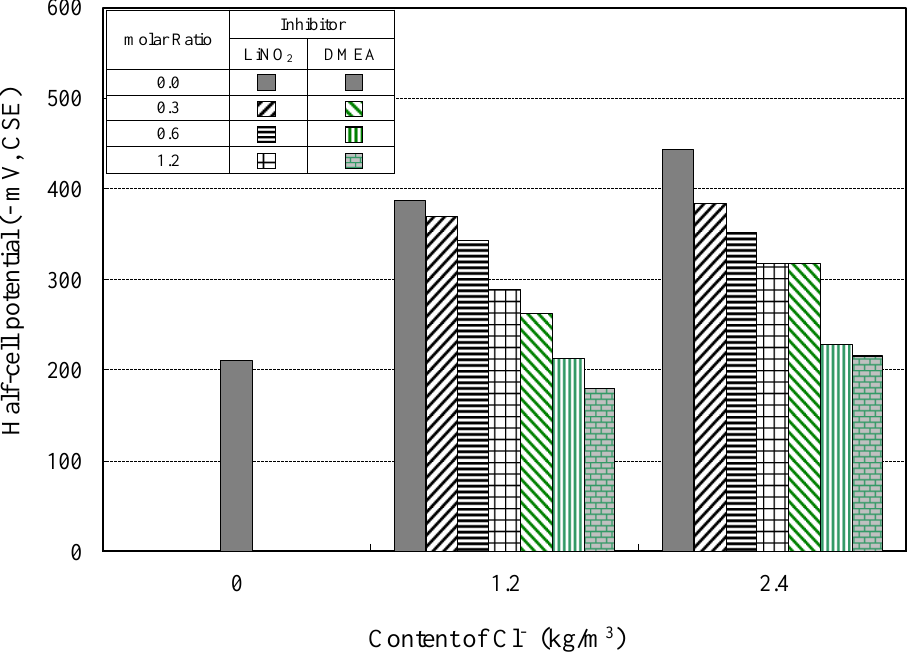
Figure 11. Corrosion potential of the rebar at different molar ratios of inhibitor.